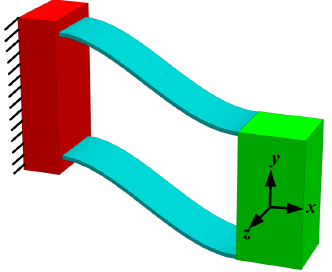
Figure 1. Parallel leaf-spring structure.